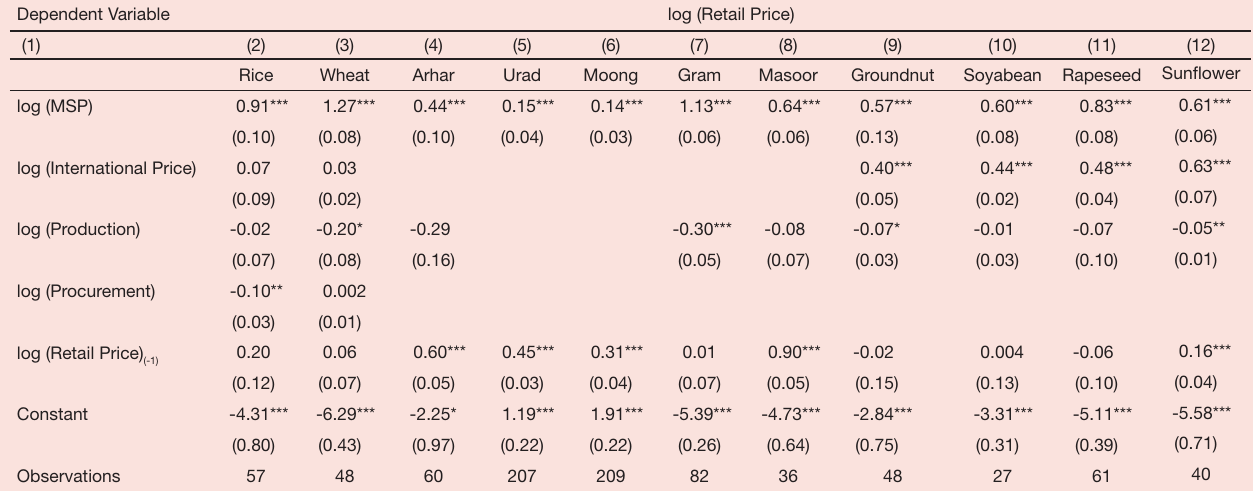
Table 2: annual Data Panel